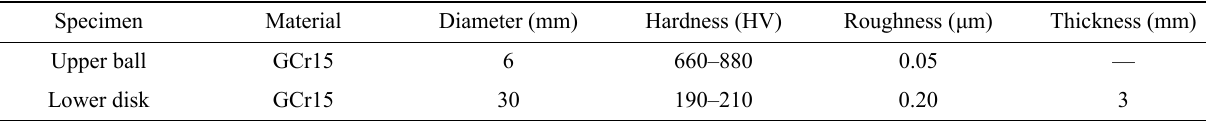
Table 1 Parameters of the steel/steel contact.